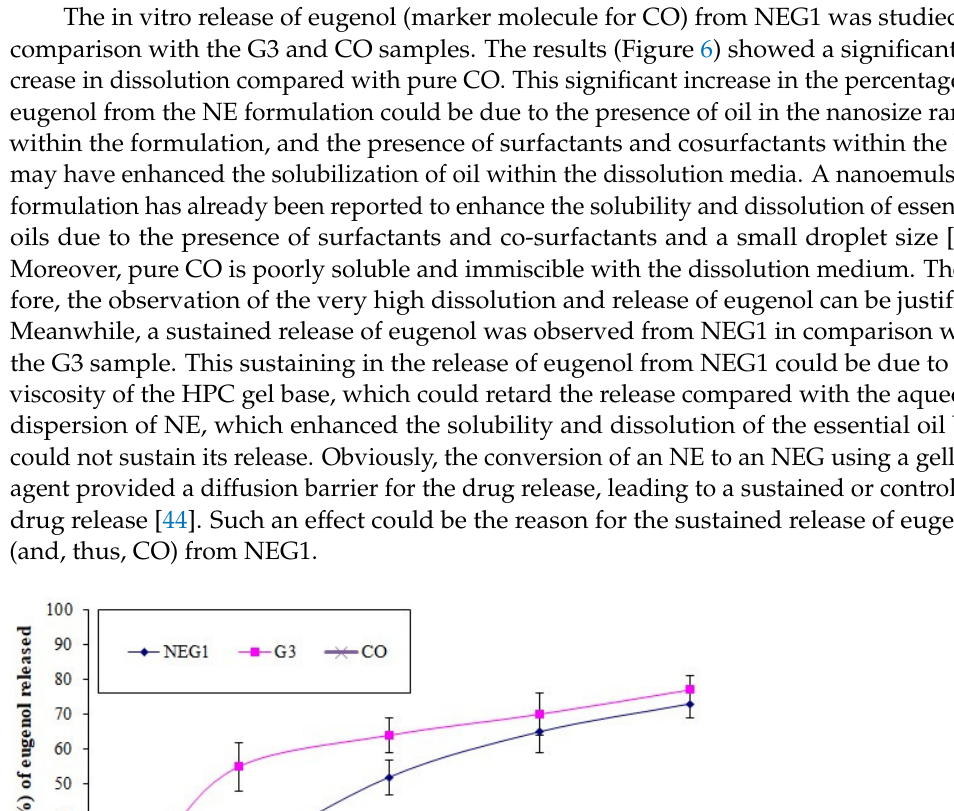
(G4) and ( b ) HPC hydrogel loaded with optimized CO-NE (NEG1). Values are expressed as the mean ± SD ( n = 3).